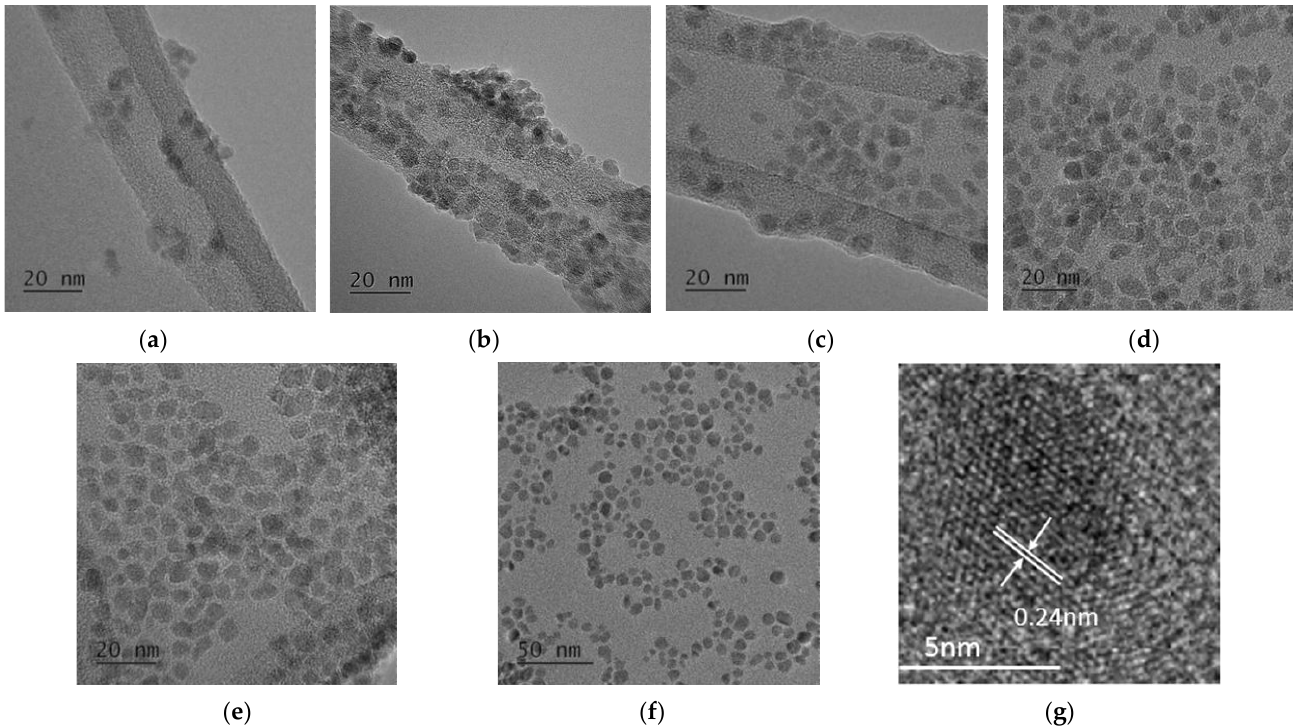
Figure 2. TEM images of CoFe 2 O 4 nanoparticles synthesized at 180 °C in the presence of 1 M oleic acid for different reaction times of 1 h ( a ), 2 h ( b ), 4 h ( c ), 8 h ( d ), 12 h ( e ), and 16 h ( f ), and HR-TEM image of samples prepared for 16 h ( g ).